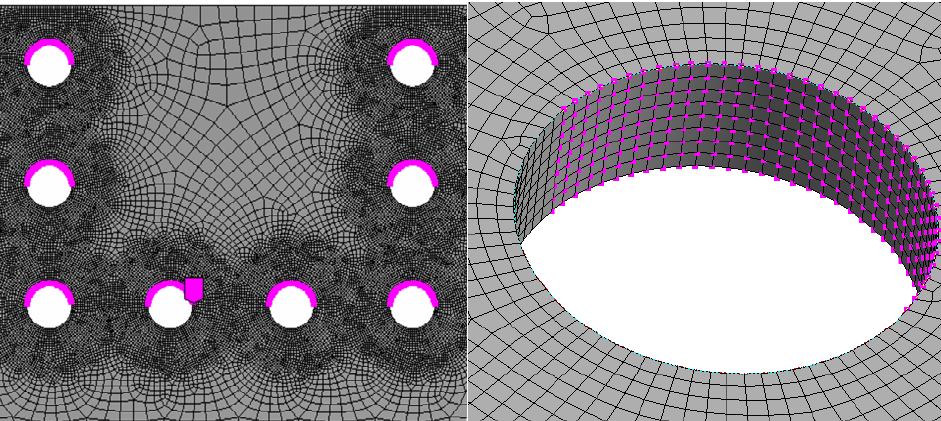
Figure 9. Mesh refinement around bolt holes in RFEM model.